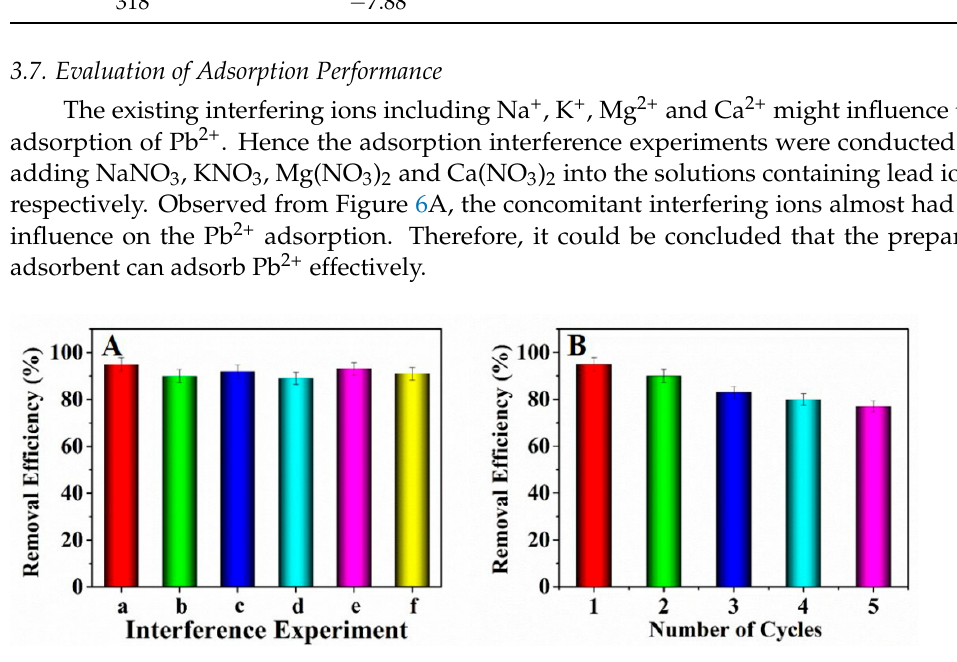
Figure 6. ( A ) Influence of interfering ions for Pb 2+ adsorption (a: blank; b: Na + ; c: K + ; d: Mg 2+ ; e: Ca 2+ ; f: mixture of the above ions); ( B ) Reusability about the prepared